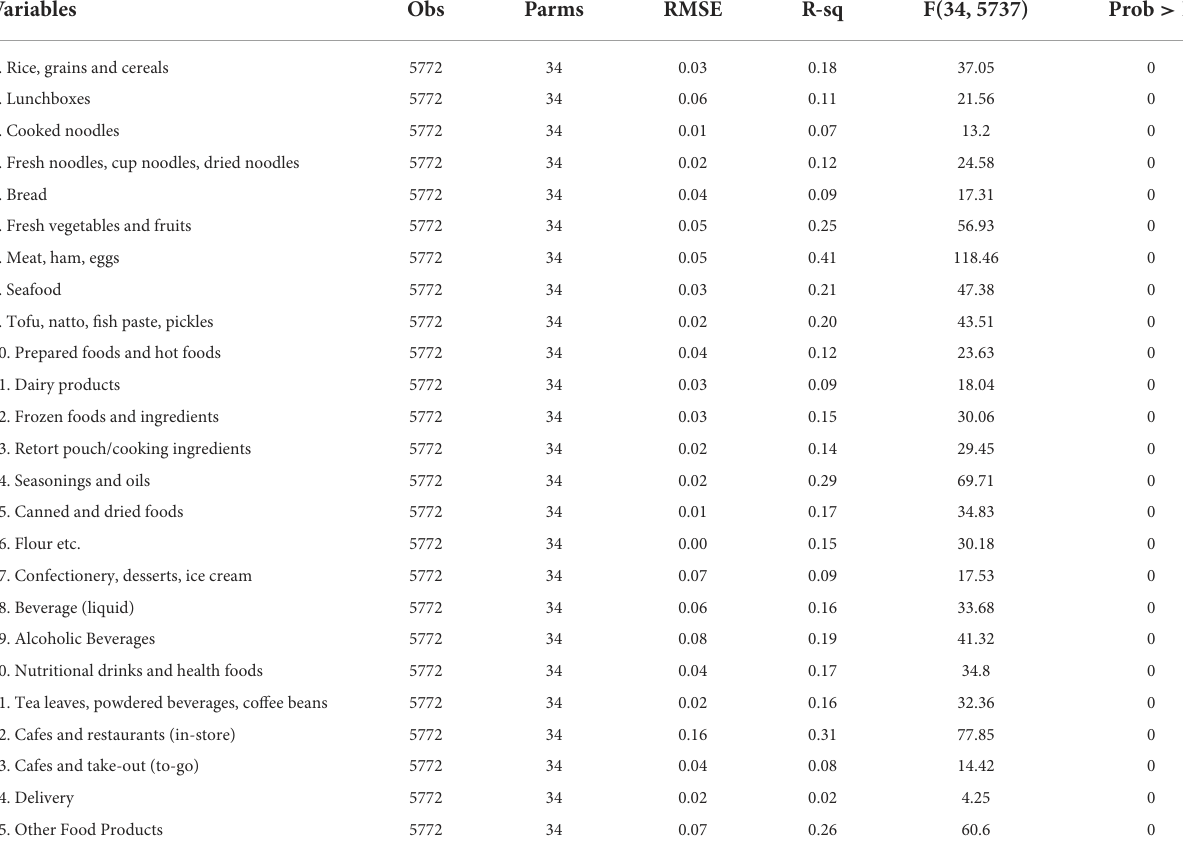
TABLE 3 Model fit of AIDS estimation with pooled data (Model